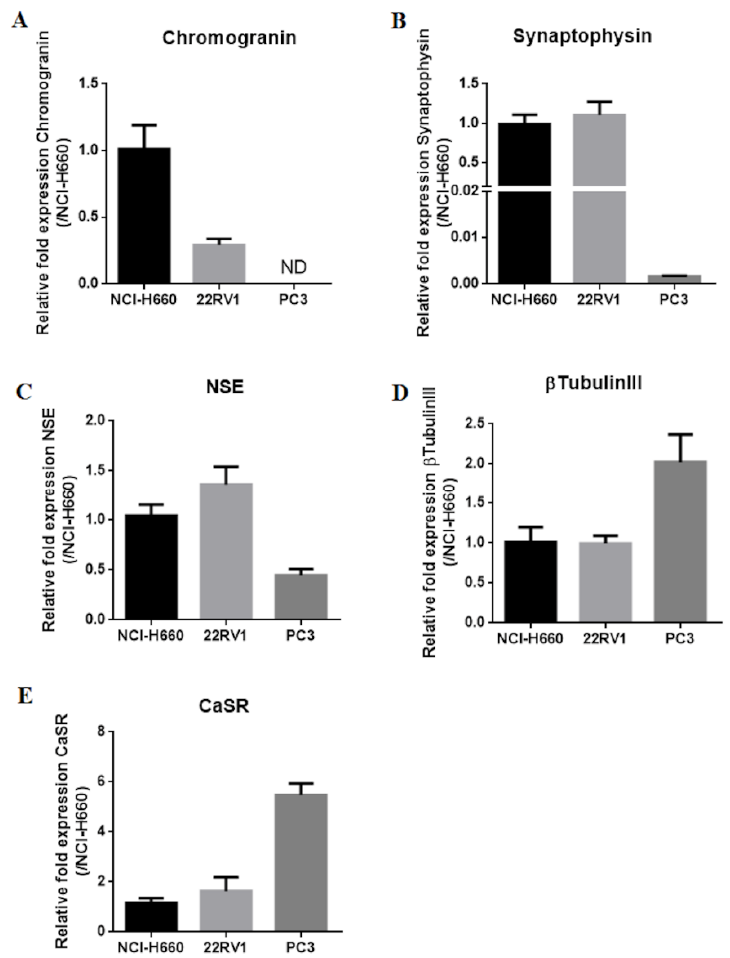
Figure 2. Neuroendocrine markers ( A – D ) in NCI-H660, PC3 and 22RV1 cell lines and Expression of CaSR ( E ). qPCR results (mean ± SEM) are expressed in 2 - ∆∆ Ct and normalized to NCI-H660 cell line.